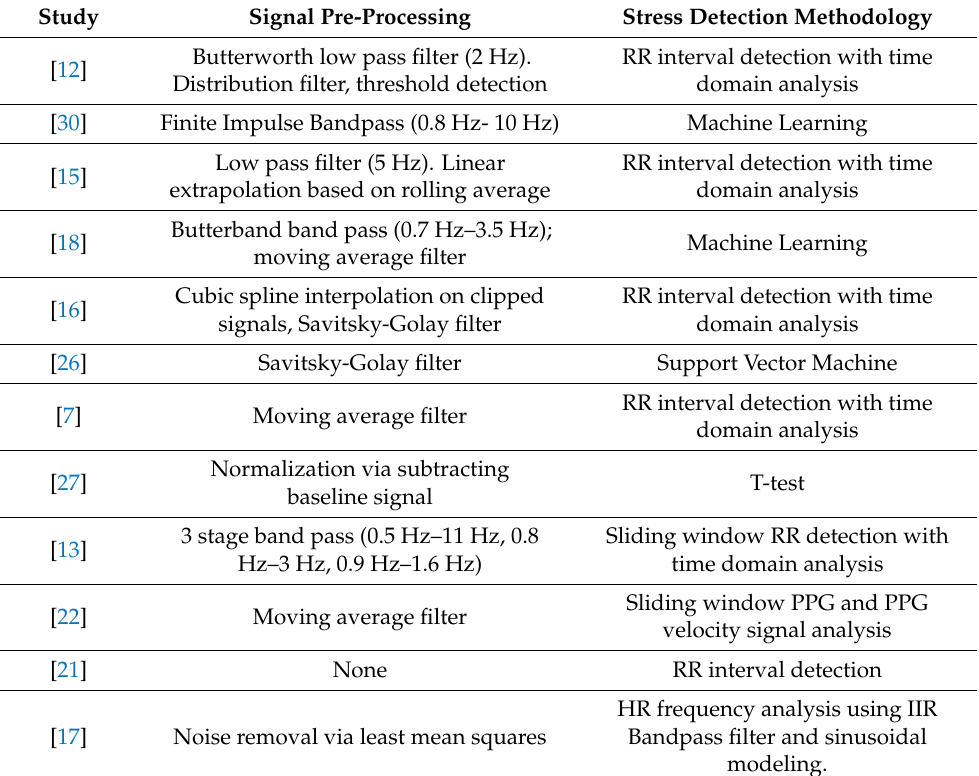
Table 4. Hardware-based methodologies for detecting stress from PPG